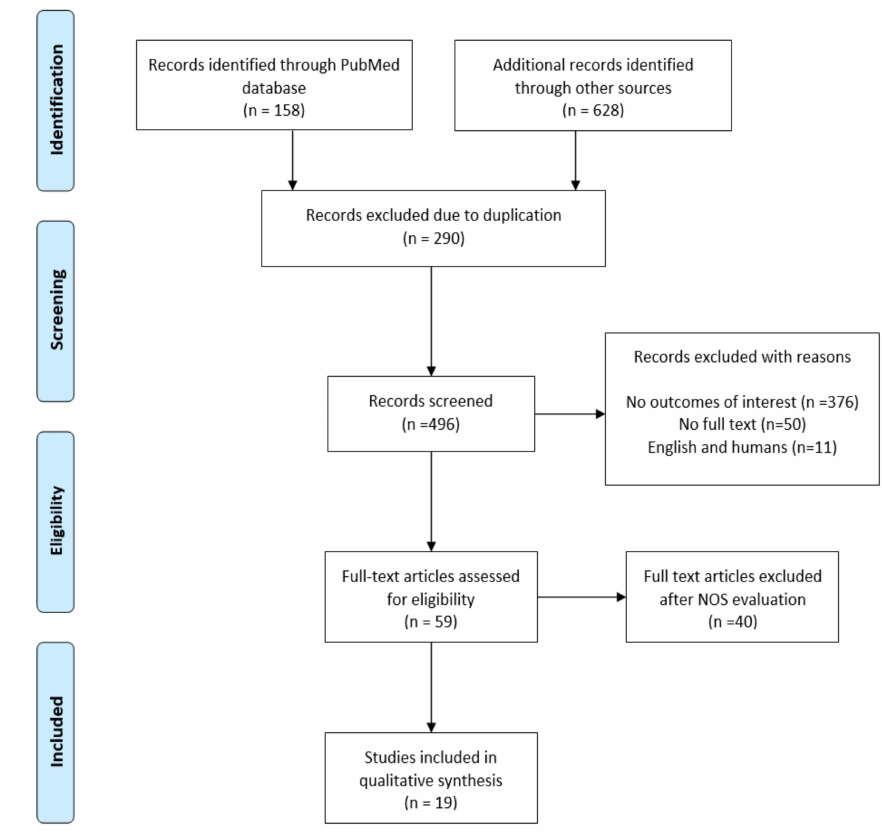
Figure 1. The study selection flow